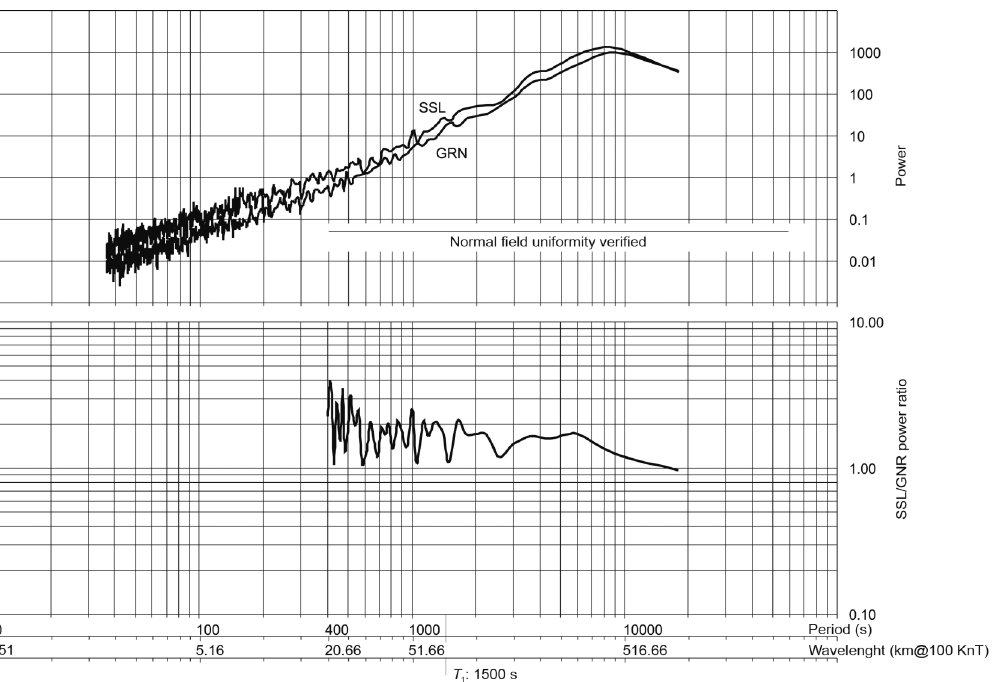
Fig. 5. Total field power spectra and power spectra ration for SSL and GRN